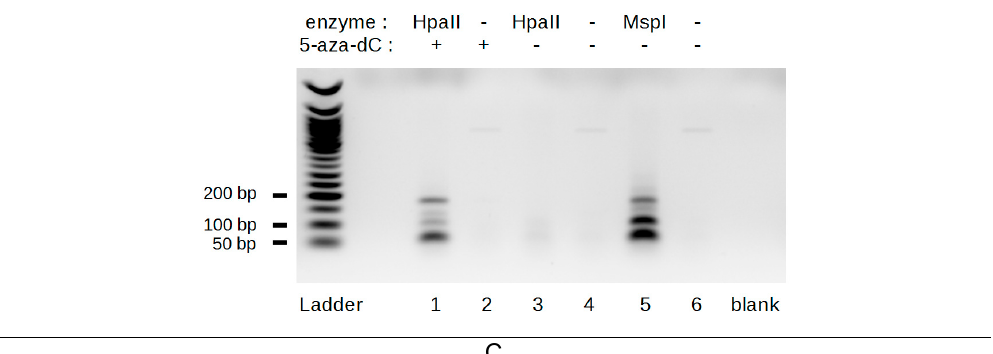
Figure 1. The 29 bp repeats of the subtelomeric CpG islands are hypermethylated in HeLa cells. (A) Schematic representation of the subtelomeric region containing CpG island. Arrowheads indicate telomeric repeats, and blue box represents the subtelomeric 29 bp repeats. The subtelomeric telomere repeat containing RNA (TERRA) transcription start site (TSS) is indicated by a black arrow. The locations of the targets for RNA guides (sub1, sub2, and sub3) are indicated by green bars. The binding sites of the Reverse Primer (PR), Oligonucleotide Template (OT) (red), and the primer pairs used for the chromatin immunoprecipitation (ChIP) (ChIP-Foward / ChIP-Reverse (ChiP-F, ChiP-R)) and primers for the qPCR of TERRA, Foward (TF) and Reverse (TR) are indicated. Sequences amplified by these two latter primer pairs are indicated by dashed lines. (B) Schematic representation of the application of the method of analysis of the cytosine methylation at 29 bp repeats. In this example, two DNA molecules with two different patterns of cytosine methylation in the 29 bp repeats are represented (blue lines). Other 29 bp repeats are represented by dotted blue lines. (1) Genomic DNA is digested by the methylation-sensitive endonuclease HpaII (the HpaII recognition sites located within each 29 bp repeat are indicated by orange arrowheads). (2) After hybridization of the 3 ′ region of the oligonucleotide OT (red line) to the sequence adjacent to the HpaII recognition sites of the 29 bp repeats, DNA polymerase-catalyzed elongation (represented by dotted red lines) is performed in which the 5 ′ region of OT serves as template. OT is blocked at its 3 ′ end by dideoxycytidines to prevent its own elongation represented by crossed dotted red lines. (3) PCR is carried out with the Reverse Primer PR (black, complementary to a region upstream of the 29 bp repeats) and Forward Primer (PF) (purple, complementary to sequence added at the 3 ′ end of the cleaved DNA molecules). In this example, PCR products of two different sizes are obtained depending of the methylation pattern of the region. (C) Validation of the method was performed by analysis of 1 µg of genomic DNA extracted from HeLa cells untreated or treated with 5-aza-dC was undigested or digested by HpaII (methyl sensitive) or MspI (methyl insensitive). A sample without DNA (blank) was used as negative control. Elongation products (1/20 of the reaction) were amplified by PCR (35 PCR cycles). PCR products were run on a 1.5% BET-agarose gel. Ladder is the 50 bp DNA ladder (New England